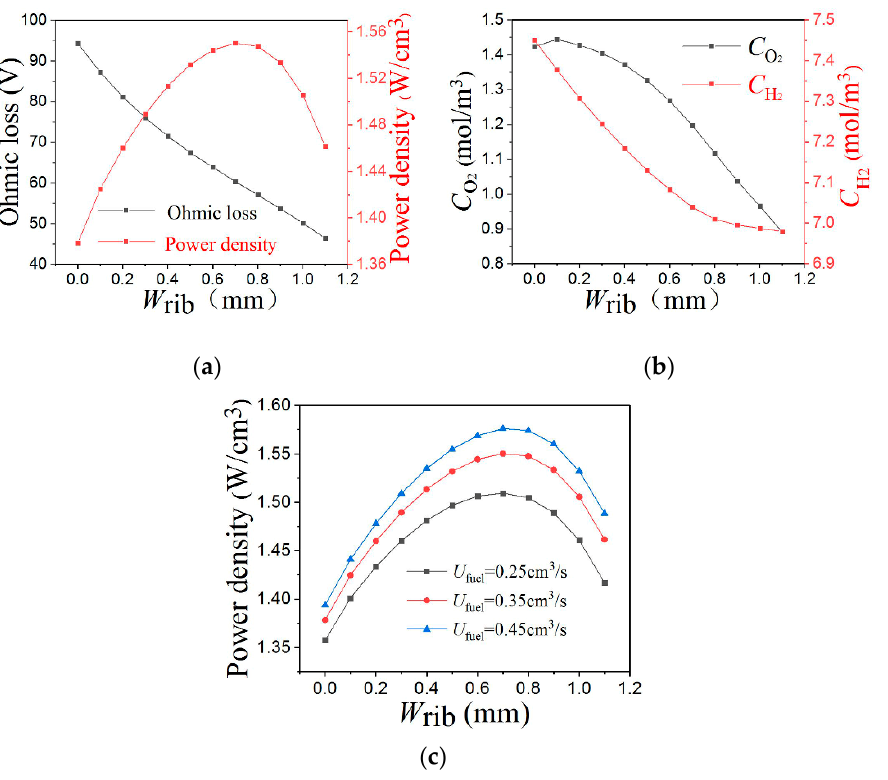
Figure 9 . Influence of vertical rib width on: ( a ) ohmic loss and power density; ( b ) gas concentration; ( c ) the effect of inlet gas volume flow .